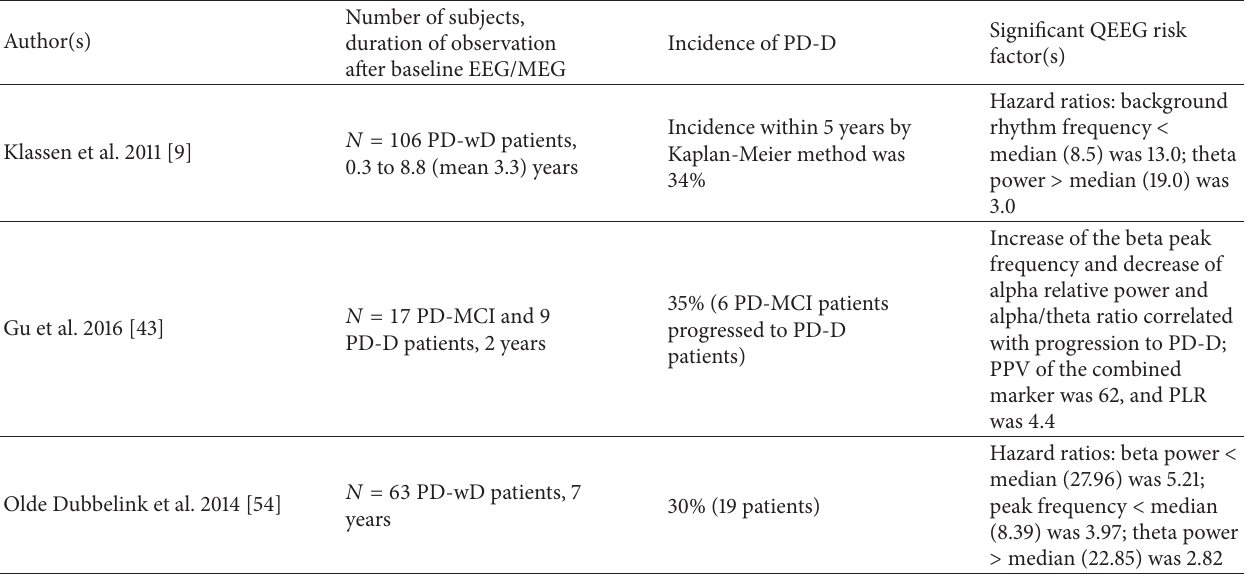
Table 4: Prediction of progression to dementia in Parkinson’s disease with spectral EEG